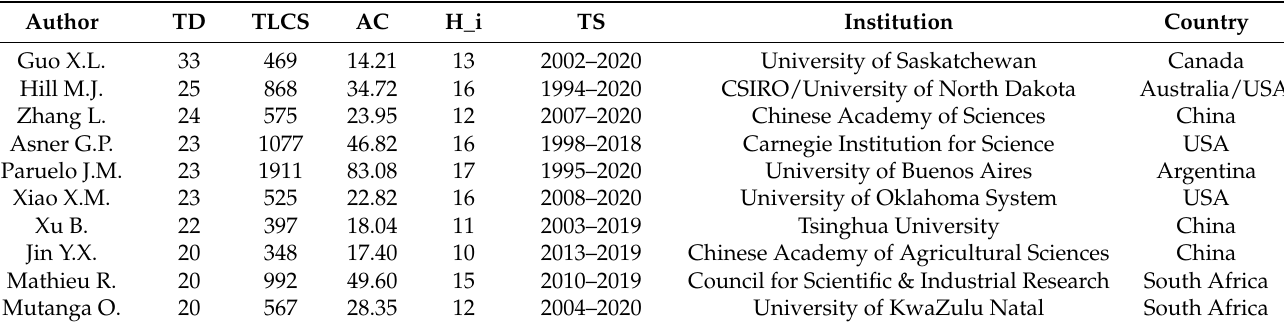
Table 4. Top 10 research authors’ local impact ranked by total